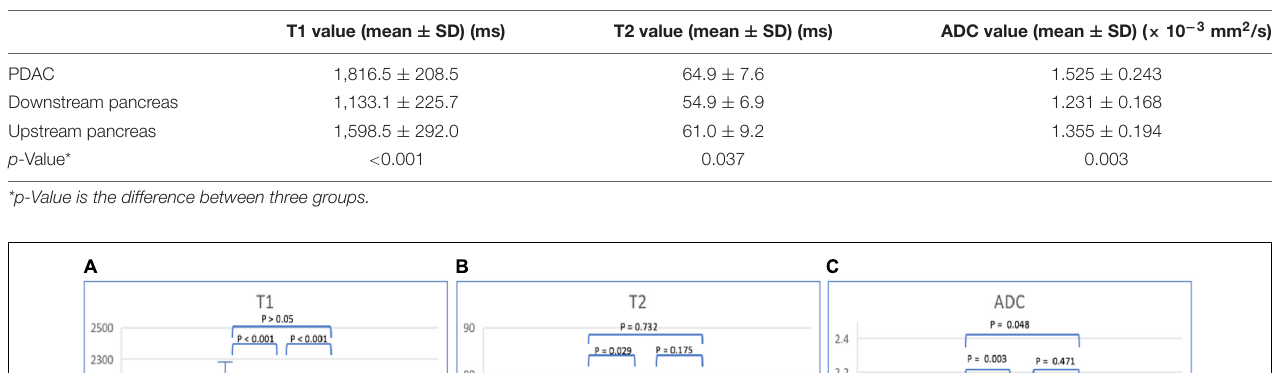
TABLE 3 | T1, T2, and ADC values of the PDAC, downstream, and upstream.